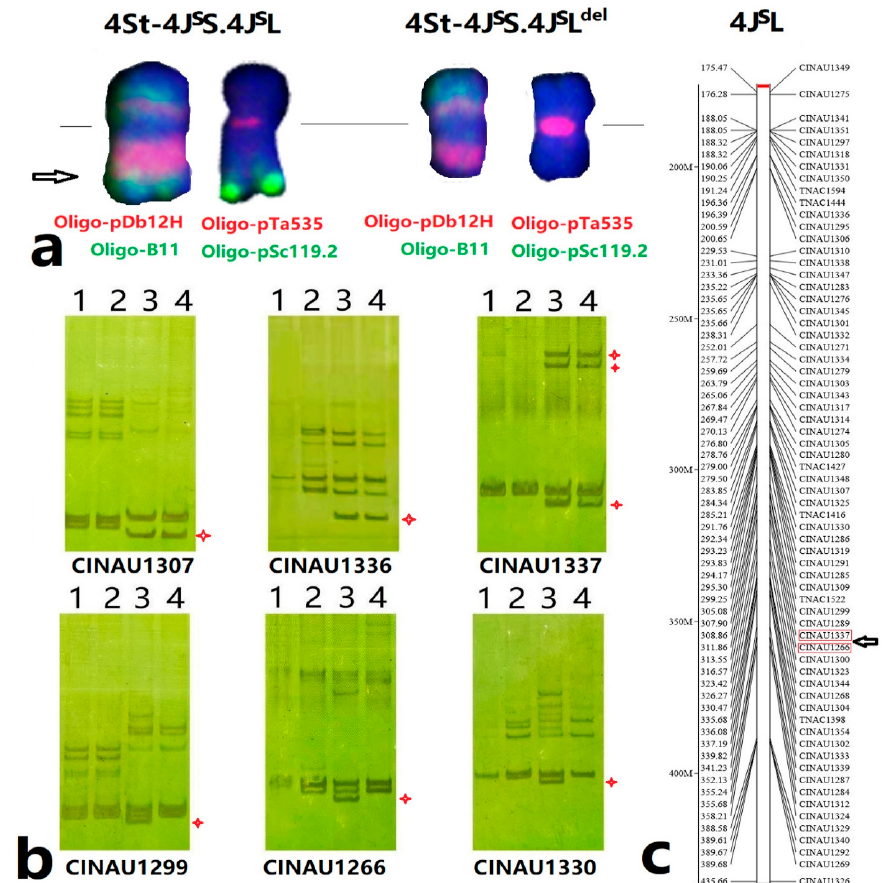
Figure 6. Physical location of the break point of 4St-4J S S.4J S L deletion detected using FISH and molecular markers. ( a ) The comparative FISH patterns of the 4St-4J S S.4J S L and 4St-4J S S.4J S L del . Arrow shows the break point location. ( b ) The PCR amplification of CINAU markers for the lines (1) CS, (2) MY11, (3) X479 and (4) M931. The stars show the 4J S L amplifications. ( c ) The 4VL-specific CINAU markers were blasted to locate on the 4J S L of Thinopyrum intermedium genome sequence of v2.1. The break point in 4J S L is shown by an arrow.